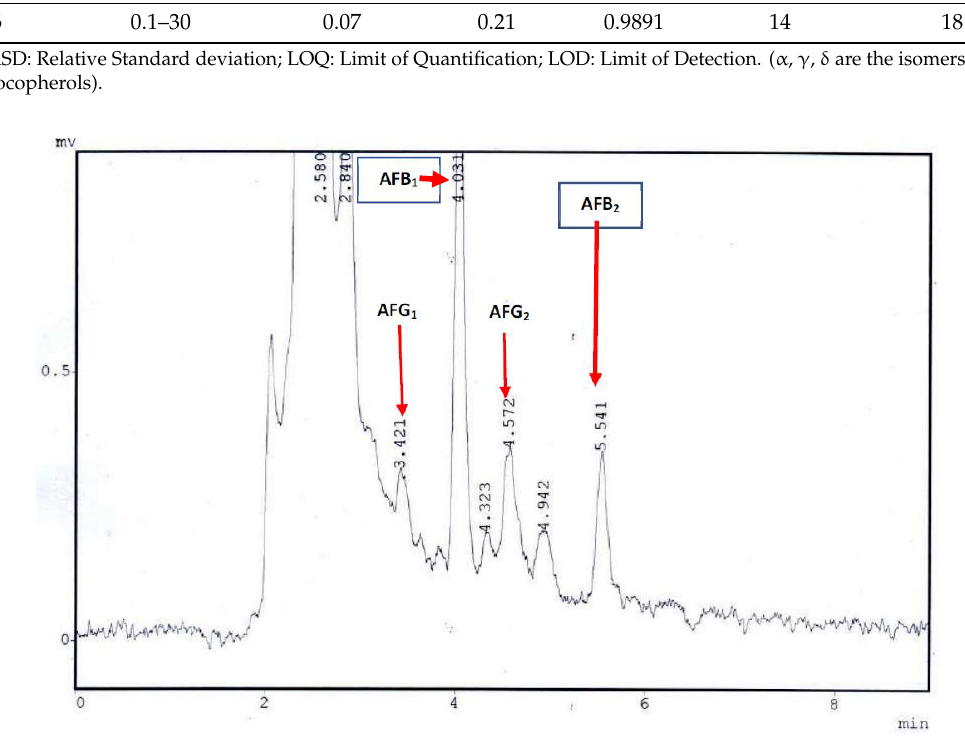
Figure 1. The natural occurrence of individual peaks corresponding to AFB 1 , AFG 1 , AFB 2 , and AFG 2 in a pumpkin without shell seed sample.